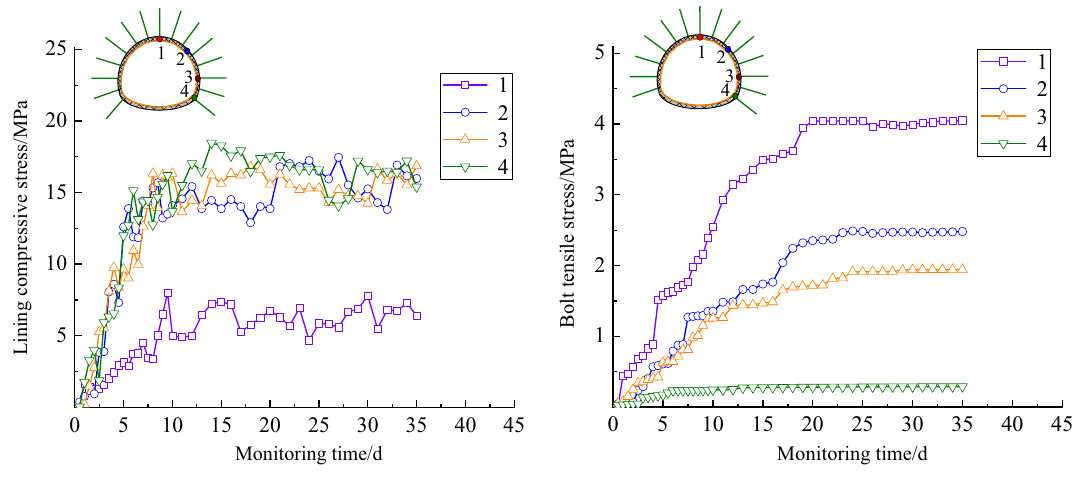
Figure 12. Field monitoring curve of the Baoshan